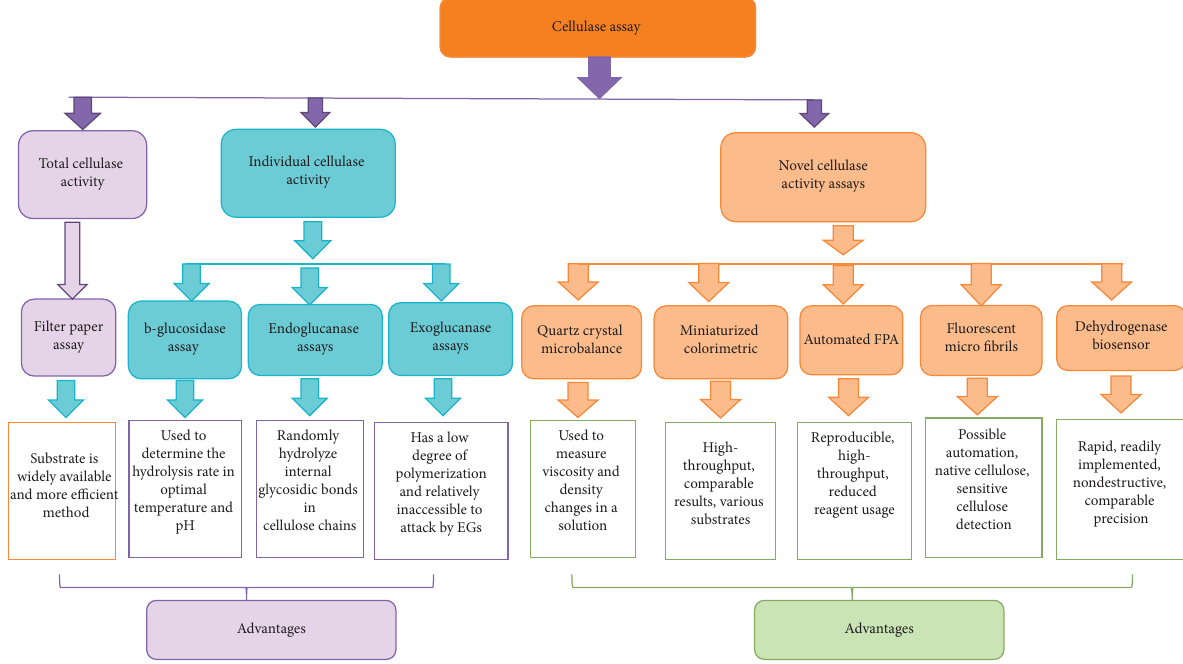
Figure 4: Diferent types of cellulase assay and